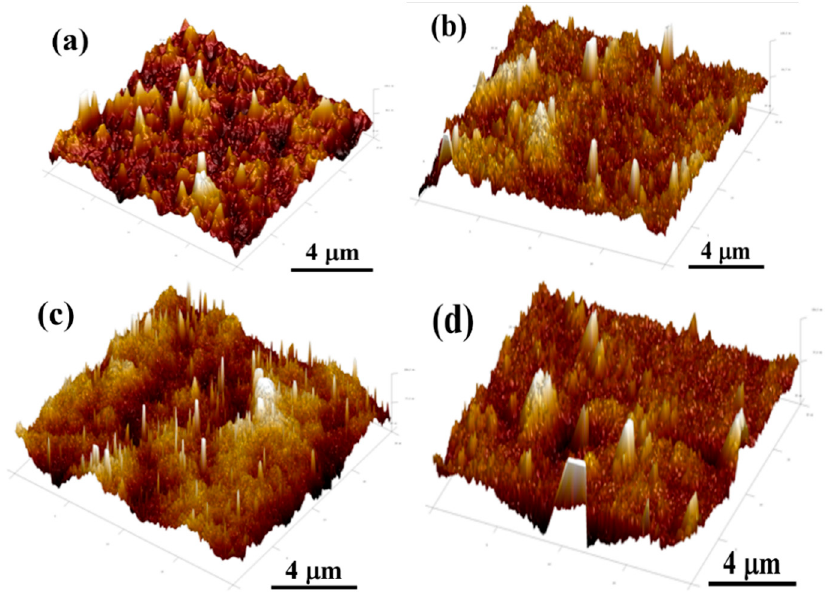
Figure 10. The 3D AFM micrographs of the surface of PLA and its biocomposites: ( a ) PLA, ( b ) PLA/Ac-lignin, ( c ) PLA/At-lignin, ( d ) PLA/By-lignin.